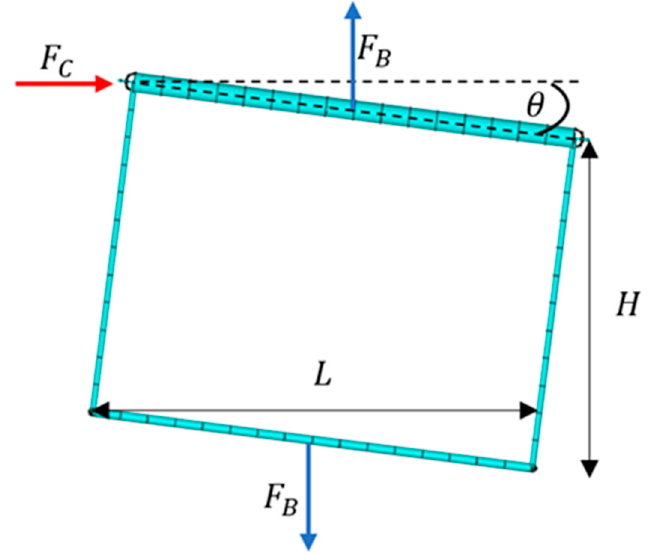
Figure 4. Applied current and buoyancy loads F C , F B accordingly, on a cage hinged at the end, indicating the angle of pitch θ , the cage height H , and the cage length L .